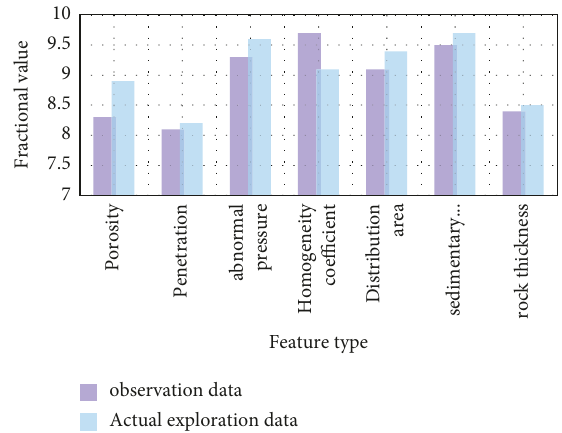
Figure 10: Comparative analysis of actual and predicted reservoir